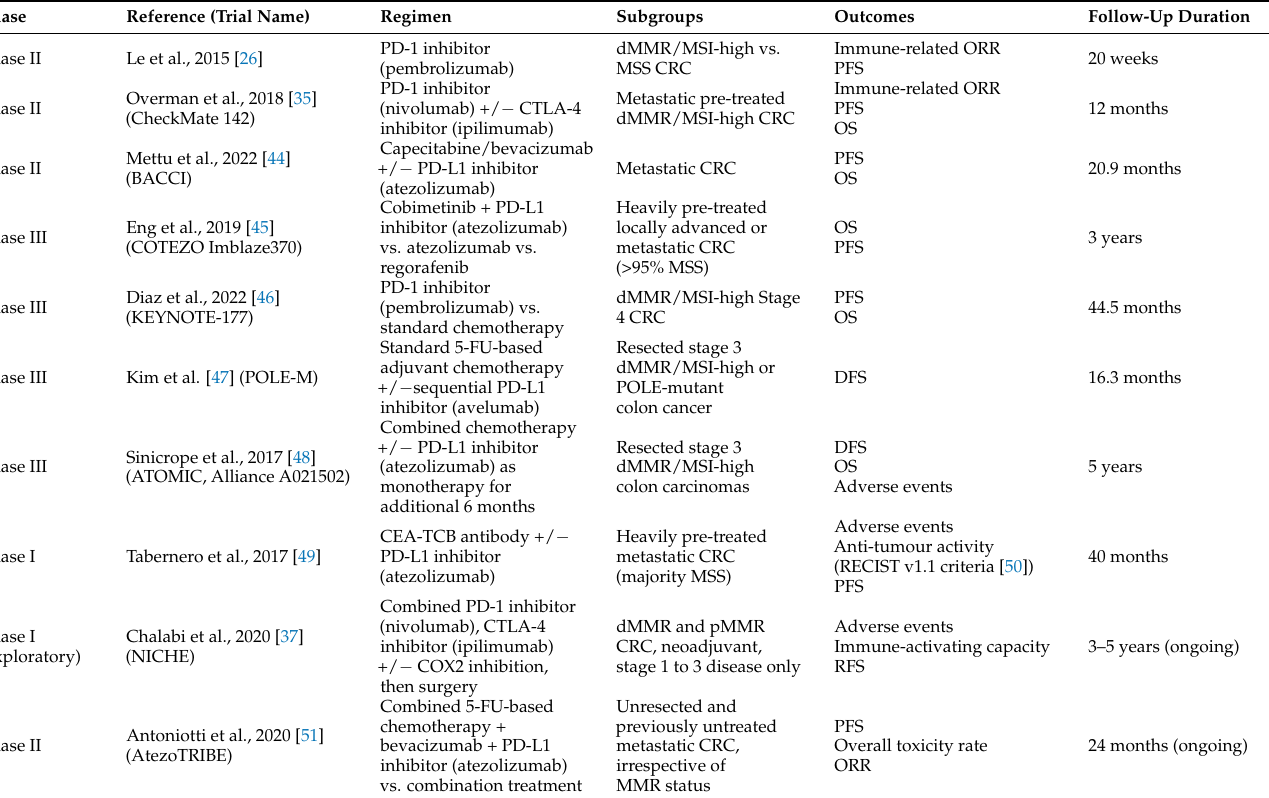
Table 1. Clinical trials of immunotherapy in CRC (adapted and expanded from Sillo et al.